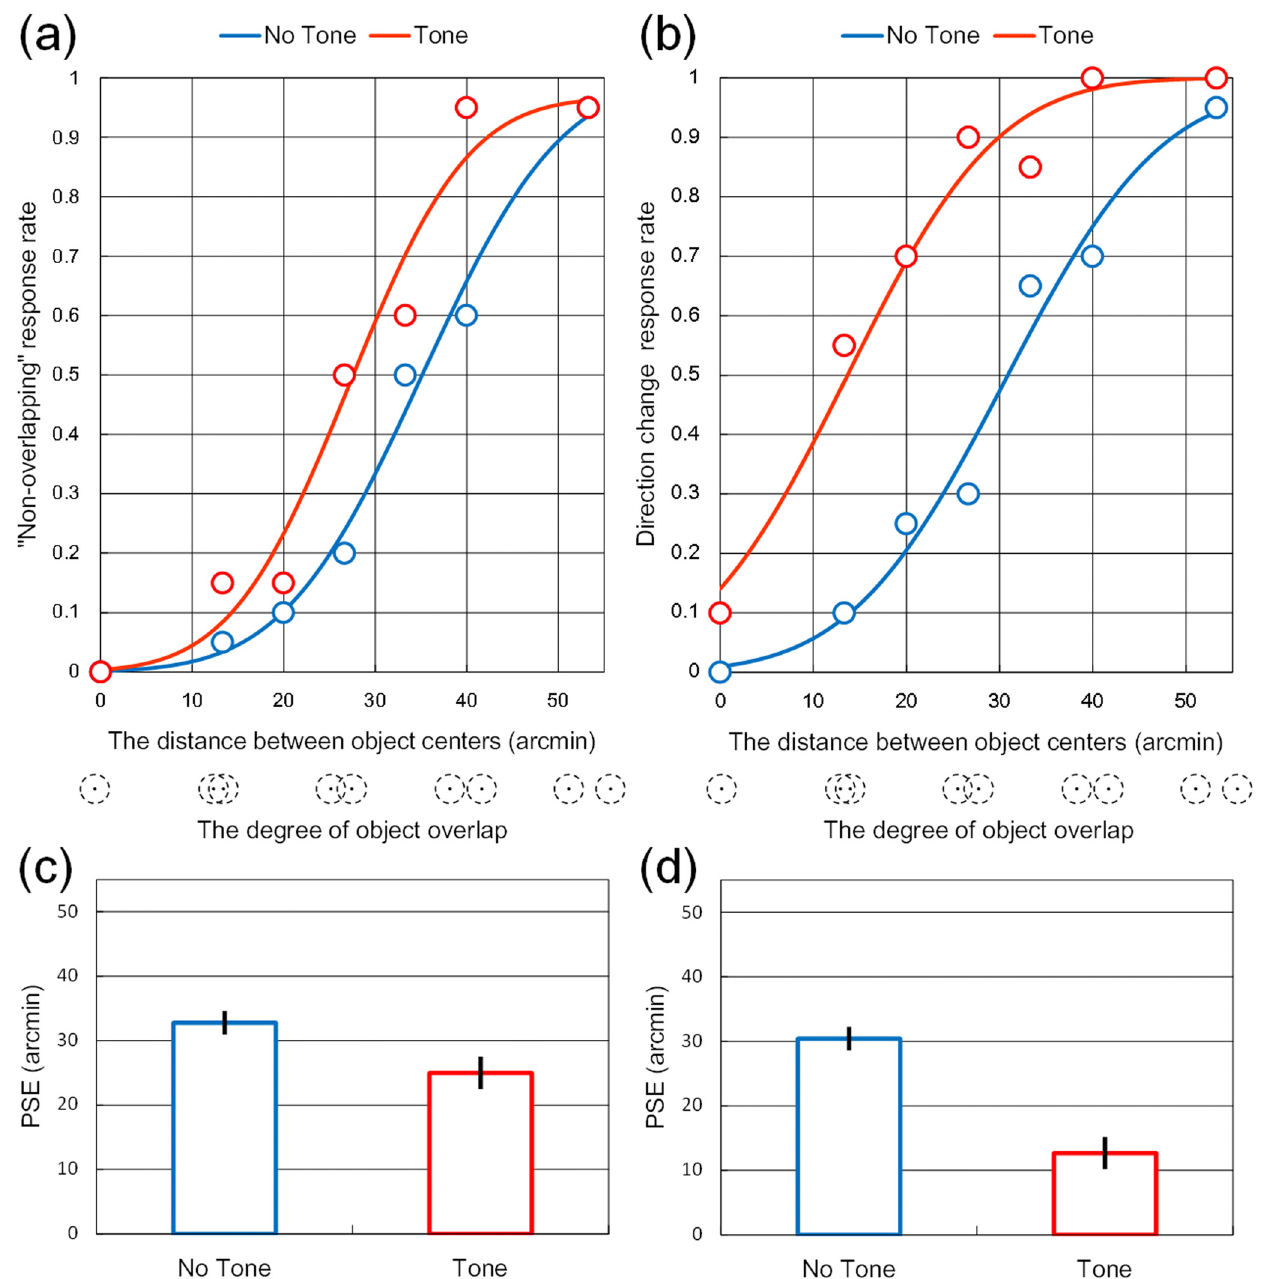
Fig 2. Results of Experiment 1. The psychometric functions fitted to “ non-overlapping ” judgment data (a) and directional change judgment data (b) from Subject 8. Below the abscissae, the degree of object overlap corresponds to the distance between object centers. Group mean PSEs for tone conditions in the (c) overlap and (d) directional change judgment tasks. Error bars denote standard errors of the mean ( n = 19).